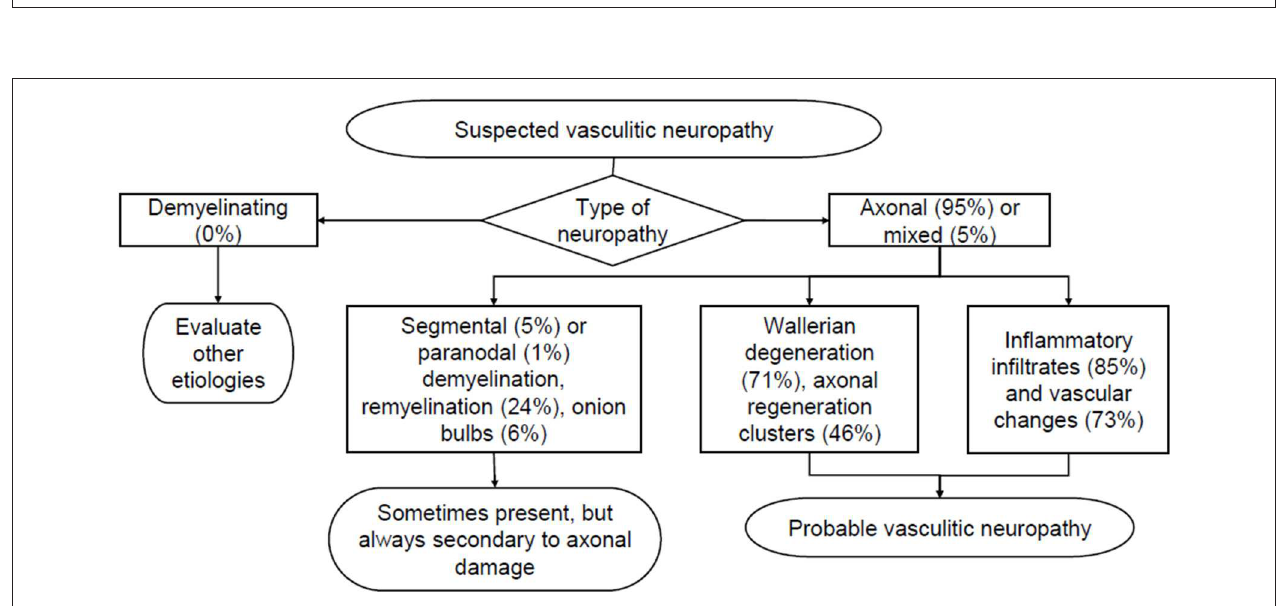
FIGURE 6 | Simplified histological diagnostic pathway in the evaluation of suspected vasculitic neuropathy. The percentages derive from the analysis of 111 biopsies suggestive of vasculitis reported at the Neurological Clinic in the period 1981–2017.